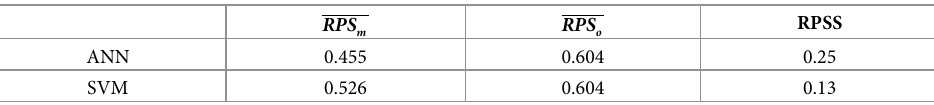
Table 3. The RPS and RPSS values of ANN and